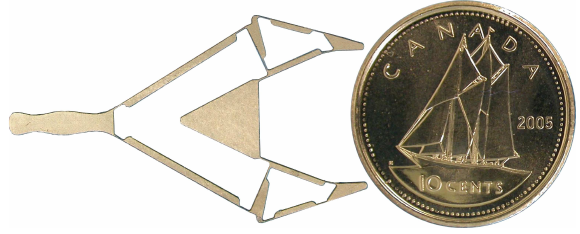
Figure 1. Sub-centimetre underactuated compliant gripper (Boudreault and Gosselin,